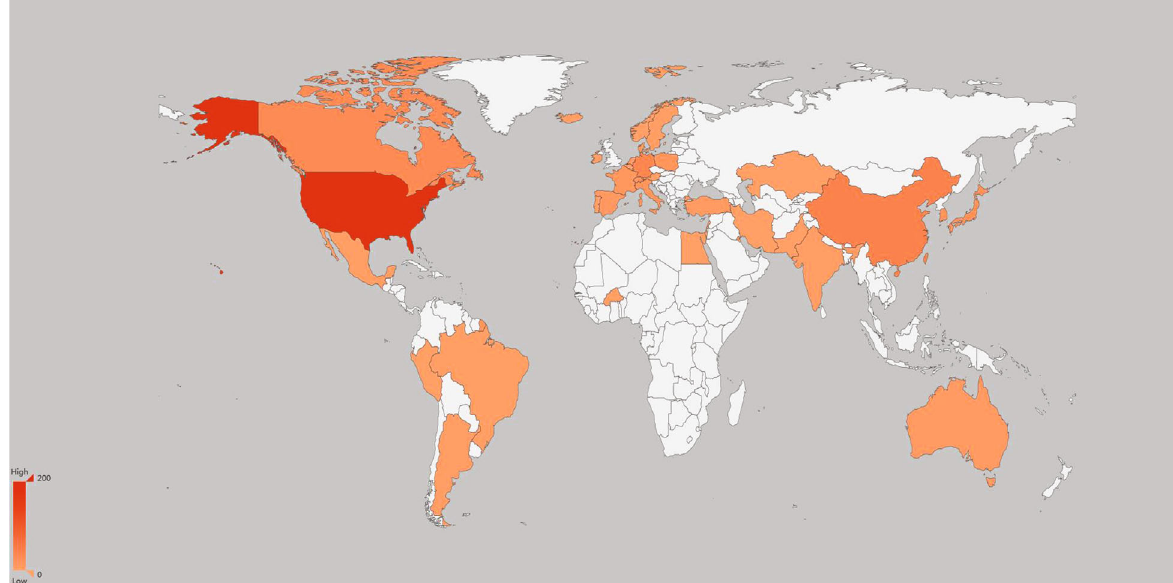
Figure 3: S1P and Aging publications per country.